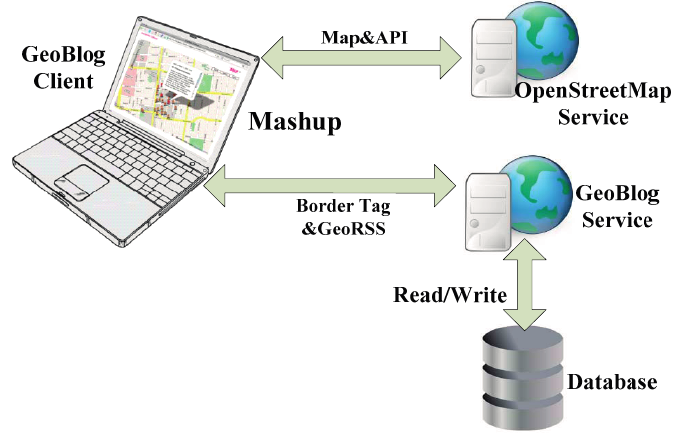
Figure 3. The frame of blog mashup with